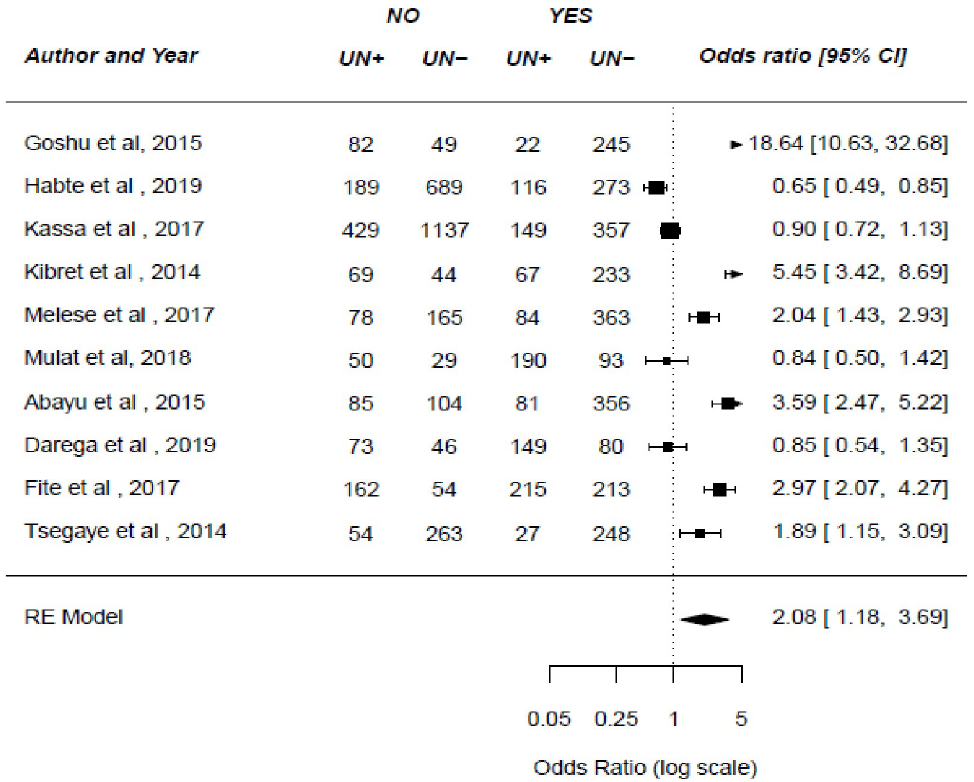
Fig 5. The pooled odds ratio of the association between the use of family planning and unintended pregnancy in Ethiopia.